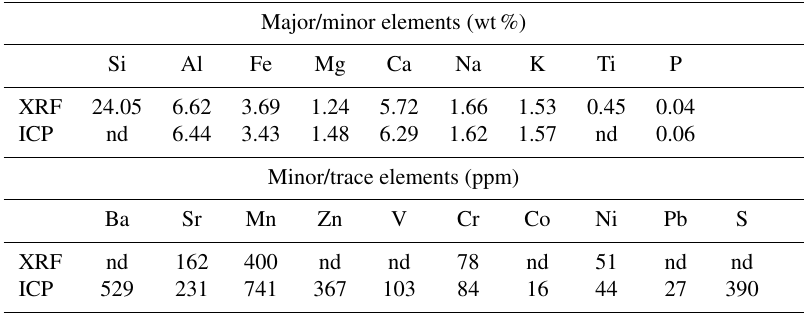
Table 3. Chemical composition of Saharan dust deposited in Granada during an extreme red rain